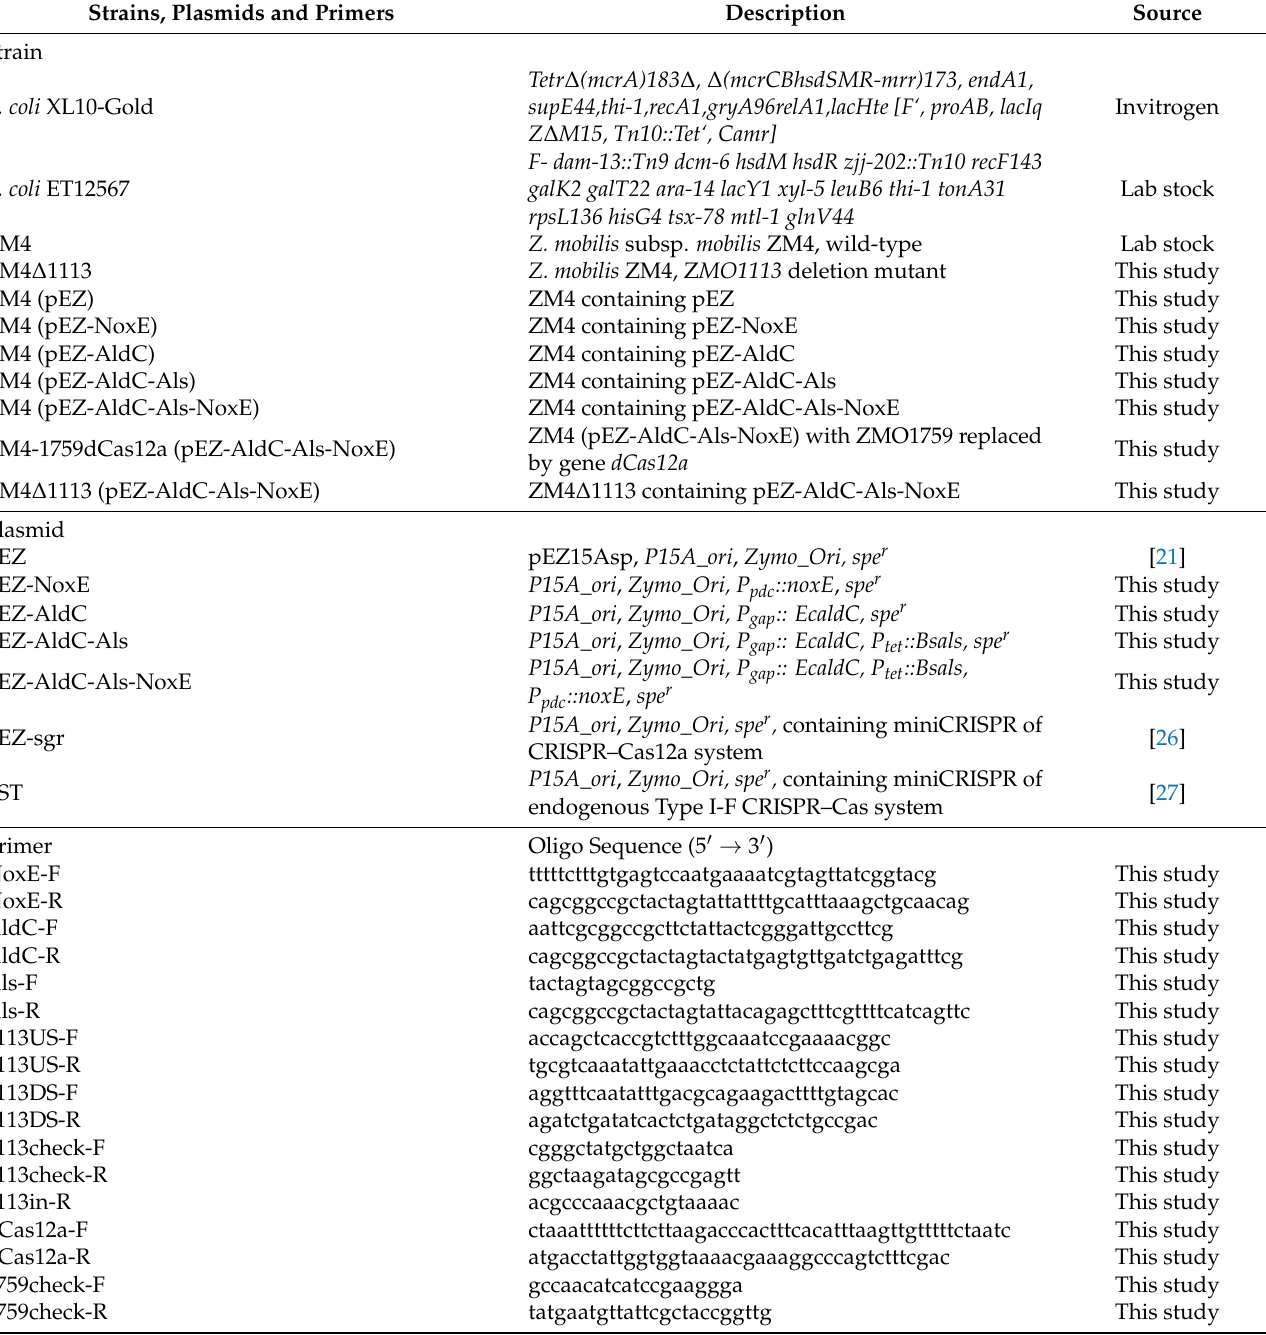
Table 1. Strains, plasmids and primers used in this